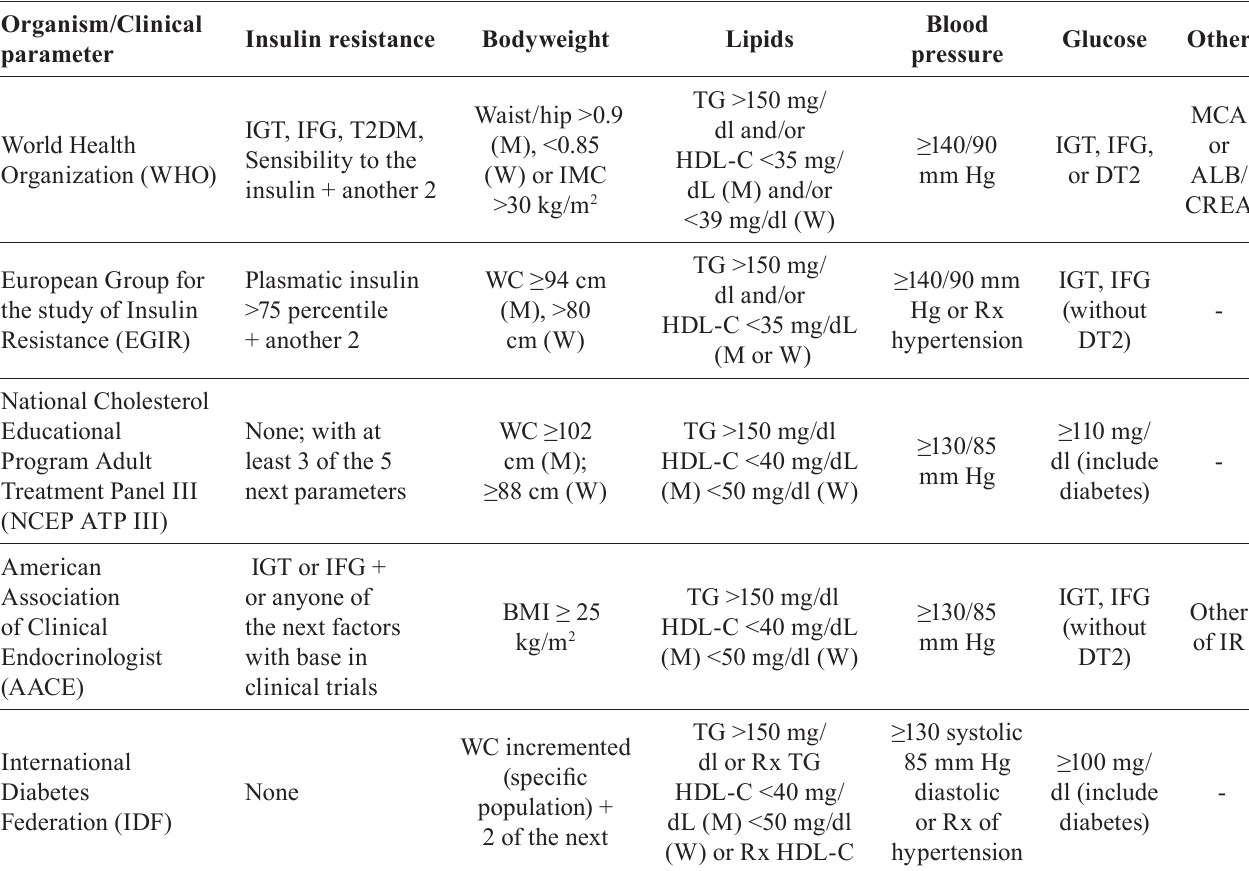
TABLE II - Clinical diagnostic criteria for metabolic syndrome (modified from Kaur, 2014)